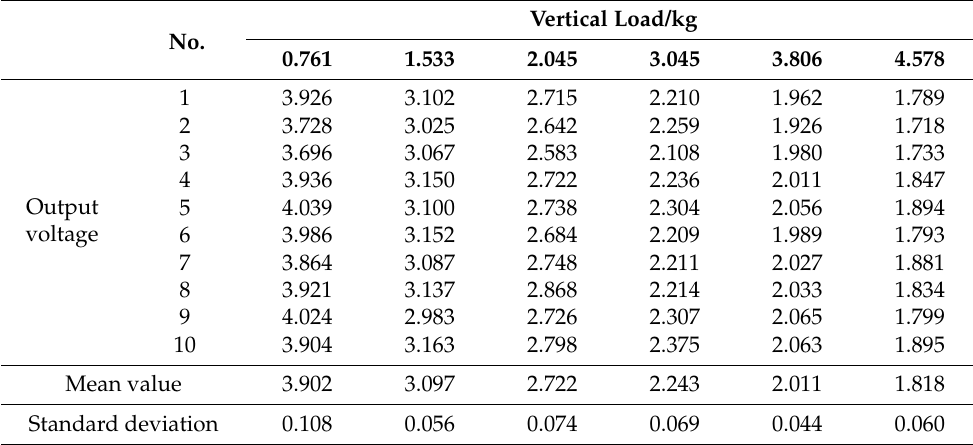
Table 7. System output voltage under different loads (unit: V).